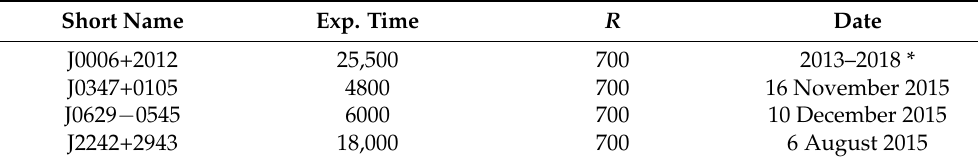
Table 1. Observational details of the spectra observed with the Asiago 1.22 m telescope. (1) Short name; (2) exposure time (seconds); (3) resolution; (4) observing date. The asterisk indicates that